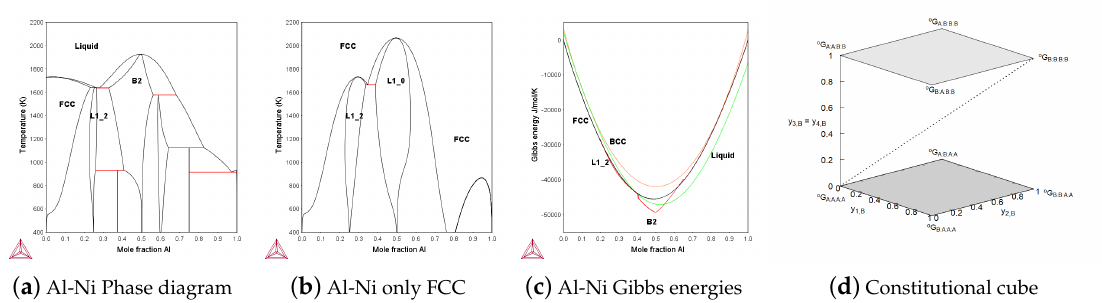
Figure 9. ( a ) The Al-Ni phase diagrams with four-sublattice CEF ordering with SRO. ( b ) The phase diagram with just the FCC phase and ( c ) the Gibbs energy curves at 1500 K across the system. ( d ) An attempt to visuallize the 4D sublattice model for FCC in an A-B system. The lower left corner is pure A and upper right pure B and the dashed line represent the disordered state. Two constituent fractions, y 3,B = y 4,B , are equal on the vertical axis. The two shaded horizontal planes represent reciprocal systems for the other two sublattices. See the text for